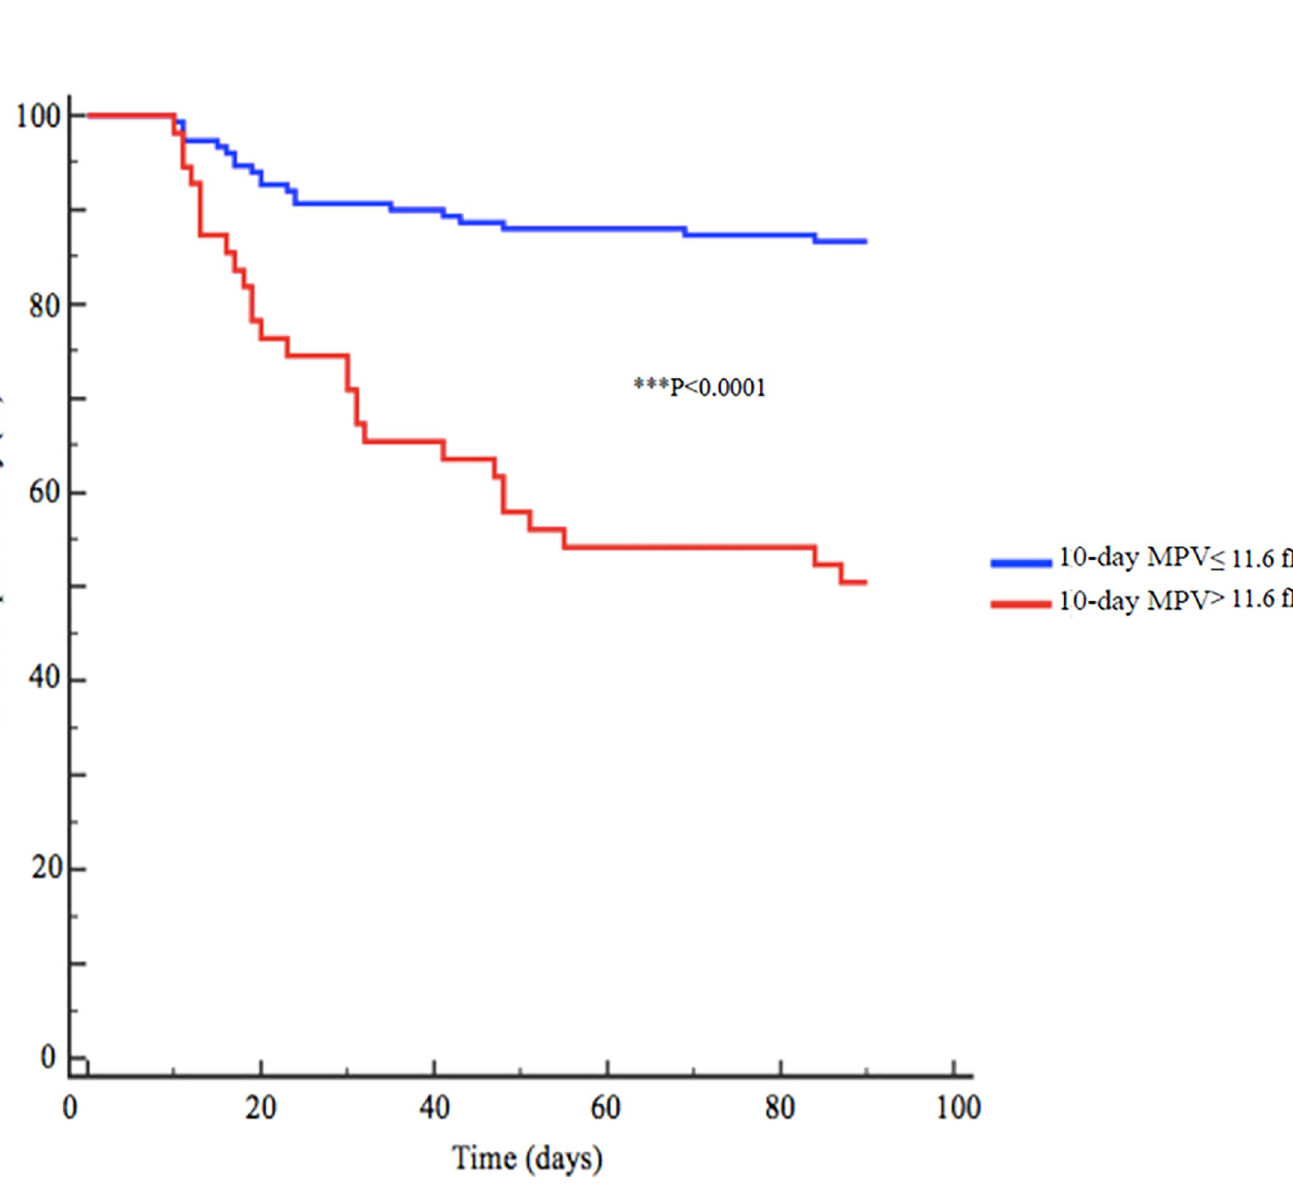
Fig 5. Survival probability Kaplan Meier curve depending on 10-Day